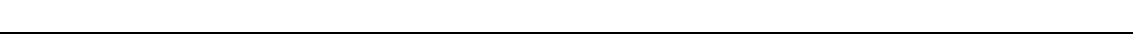
Fig. 6 Alexander disease astrocytes recapitulate key in vivo mechanosensitive markers. a Double label immuno fl uorescence and quanti fi cation demonstrate signi fi cantly increased lamin A/C expression in Alexander disease astrocytes differentiated from iPSCs (C88, bottom panel) compared to corrected control line (R88, top panel). GFAP marks astrocytes. DAPI labels nuclei. Scale bar is 10 microns. N = 58 (R88) and 94 (C88). p < 0.0001, Mann – Whitney test. b Double label immuno fl uorescence and quanti fi cation con fi rm increased nuclear/cytoplasmic (N/C) ratio of YAP protein in Alexander disease astrocytes (C88, bottom panel) compared to corrected control line (R88, top panel). GFAP marks astrocytes. DAPI labels nuclei. Scale bar is 10 microns. N = 130 (R88) and 121 (C88). p < 0.0001, Mann – Whitney test. c Double label immuno fl uorescence demonstrates increased stress fi ber formation in Alexander disease astrocytes (C88, bottom panel) compared to corrected control line (R88, top panel). Phalloidin labels F-actin. GFAP marks astrocytes. Yellow box represents a region of interest (ROI) in the soma of each astrocyte. Scale bar is 10 microns. N = 59 (R88) and 50 (C88). p < 0.0001, Mann – Whitney test. d Working model of perturbed mechanotransduction homeostasis in Alexander disease. Elevated expression of GFAP promotes F- actin formation through spectraplakin protein (blue). Consequently, F-actin promote YAP nuclear translocalization and activation via the Hippo